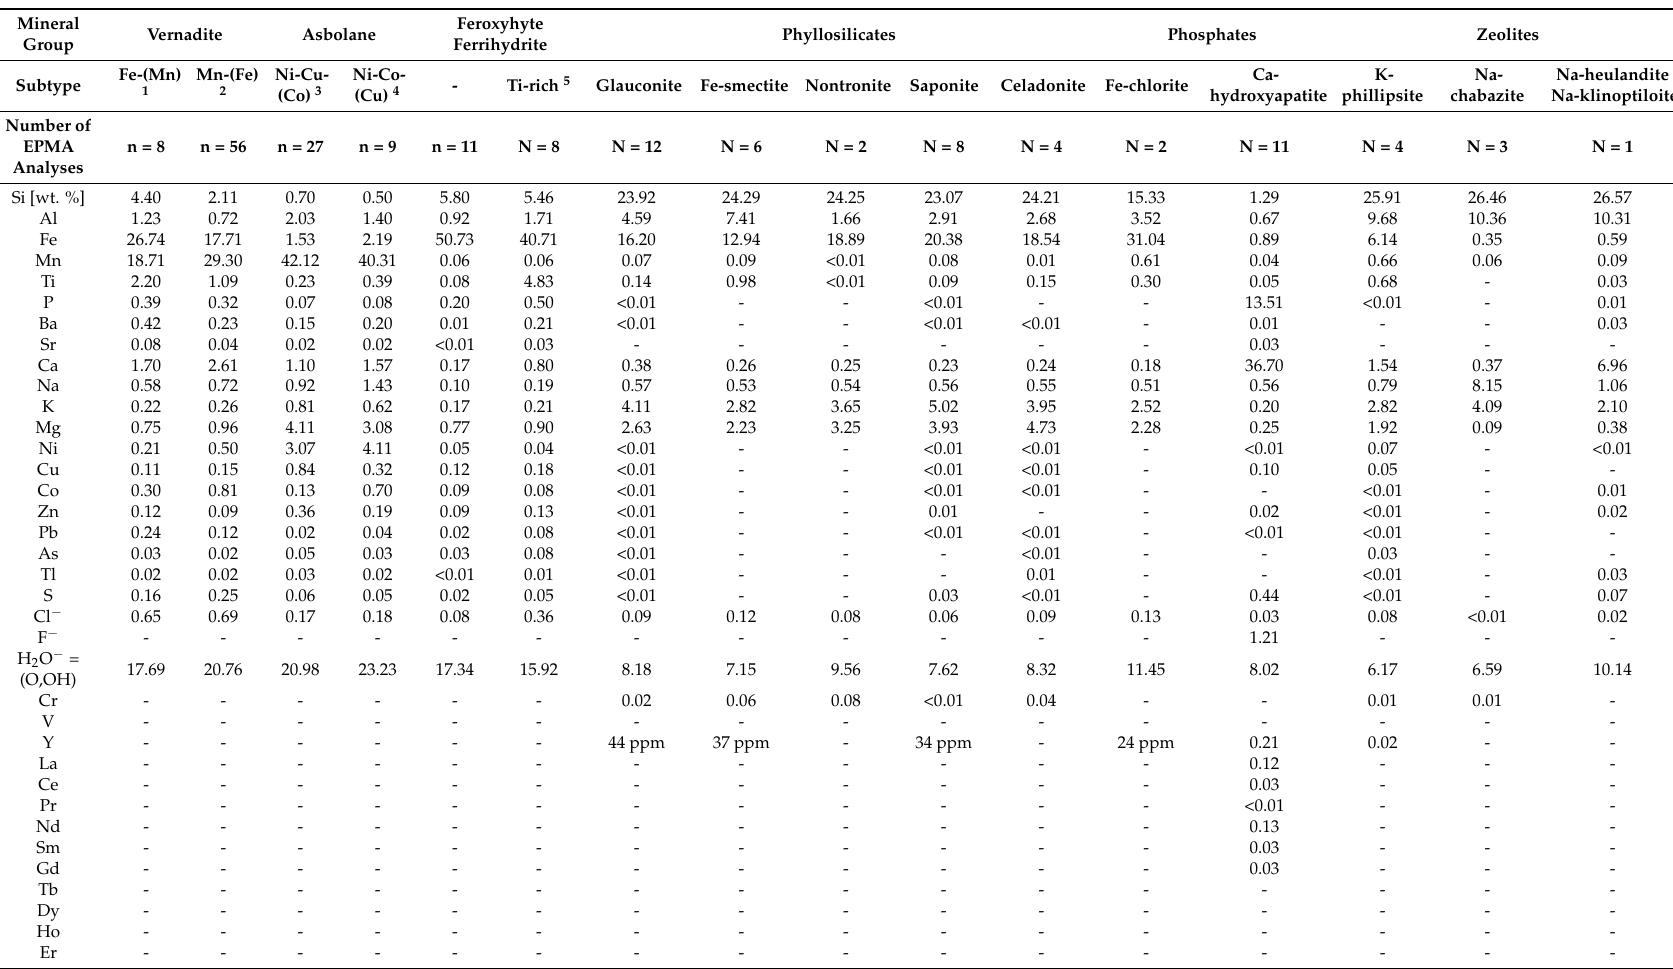
Table A1. The mean EPMA chemical results and minerals empirical formula recalculations (substrate/crust zone and Fe-Mn crust oxyhydroxide minerals). Mineral